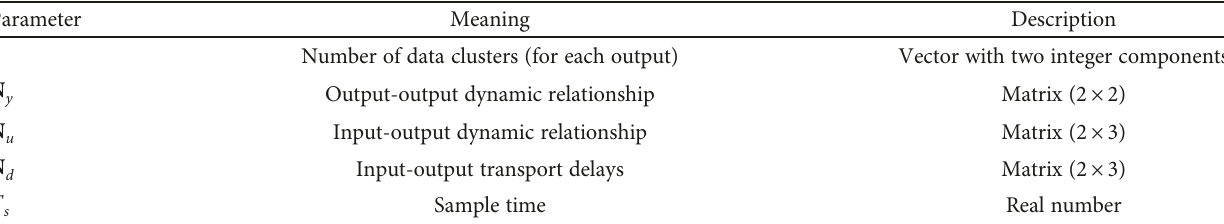
Table 3: Structural parameters for fuzzy identi fi